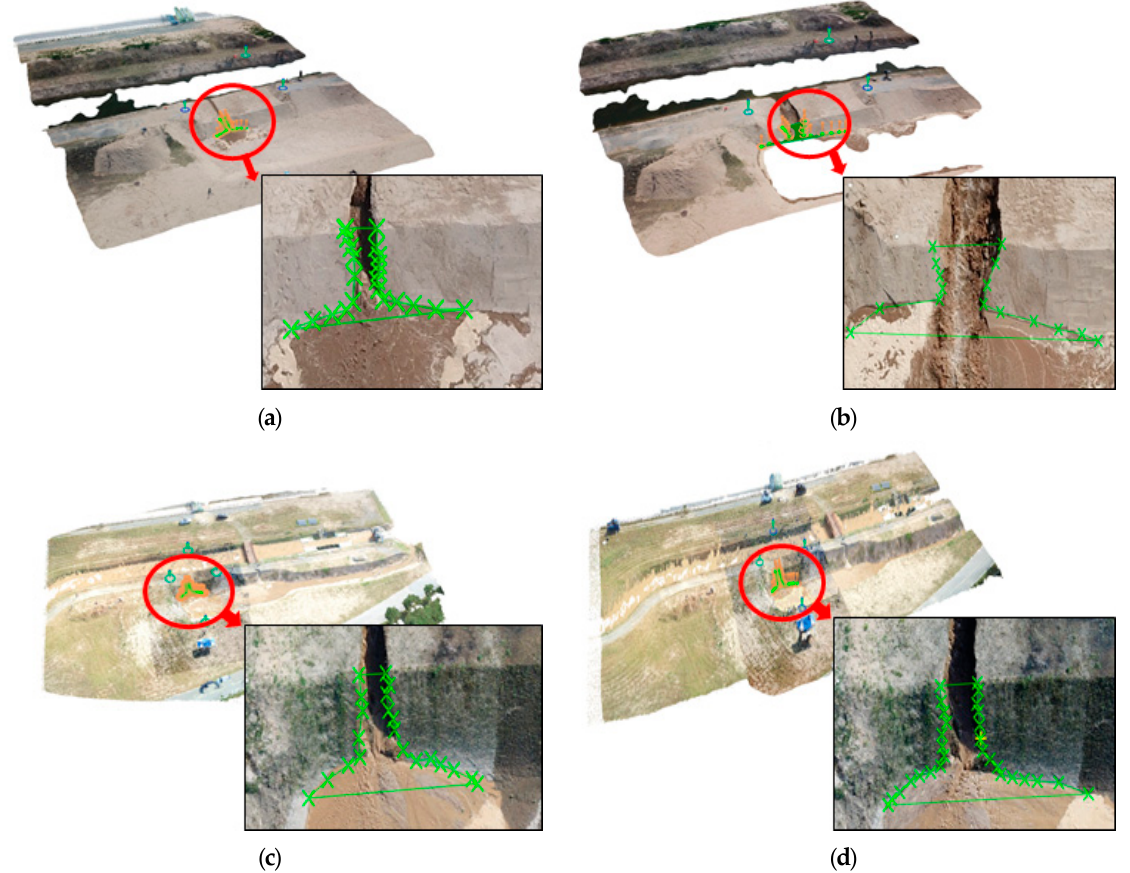
Figure 12. Surface loss rates obtained using 3D point cloud modeling; ( a ) sand levee at 6.5 min, ( b ) sand levee at 11.8 min, ( c ) reinforced novel materials levee at 40 min, and ( d ) reinforced novel materials levee at 50 min.